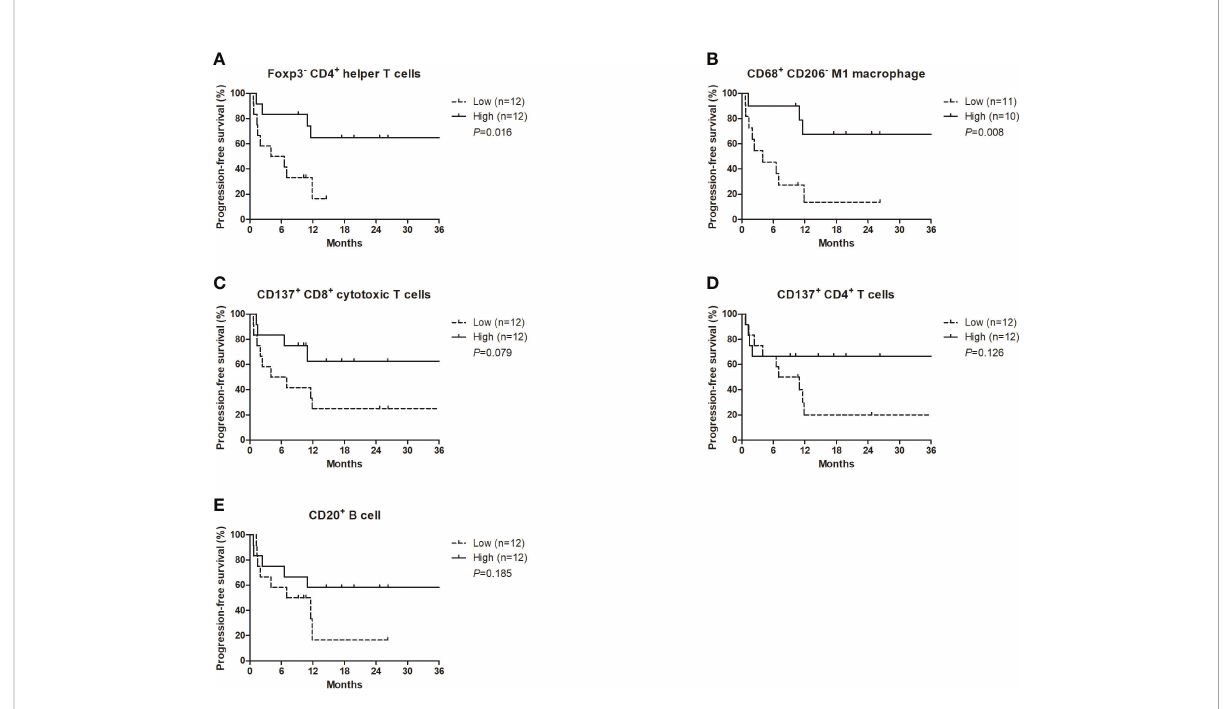
FIGURE 2 Progression-free survival with nivolumab plus ipilimumab according to the densities of certain T cell subsets, CD20 + B cells, and M1 macrophages at the tumor margin. (A) Foxp3 - CD4 + helper T cells, (B) CD68 + CD206 - M1 macrophages, (C) CD137 + CD8 + cytotoxic T cells, (D) CD137 + CD4 + T cells, (E) CD20 + B